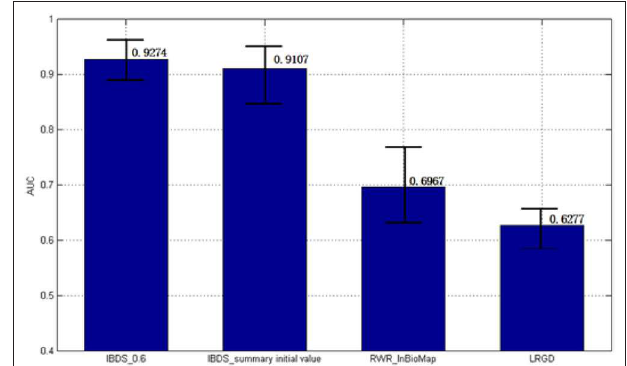
FIGURE 6 | The AUC results of different methods.